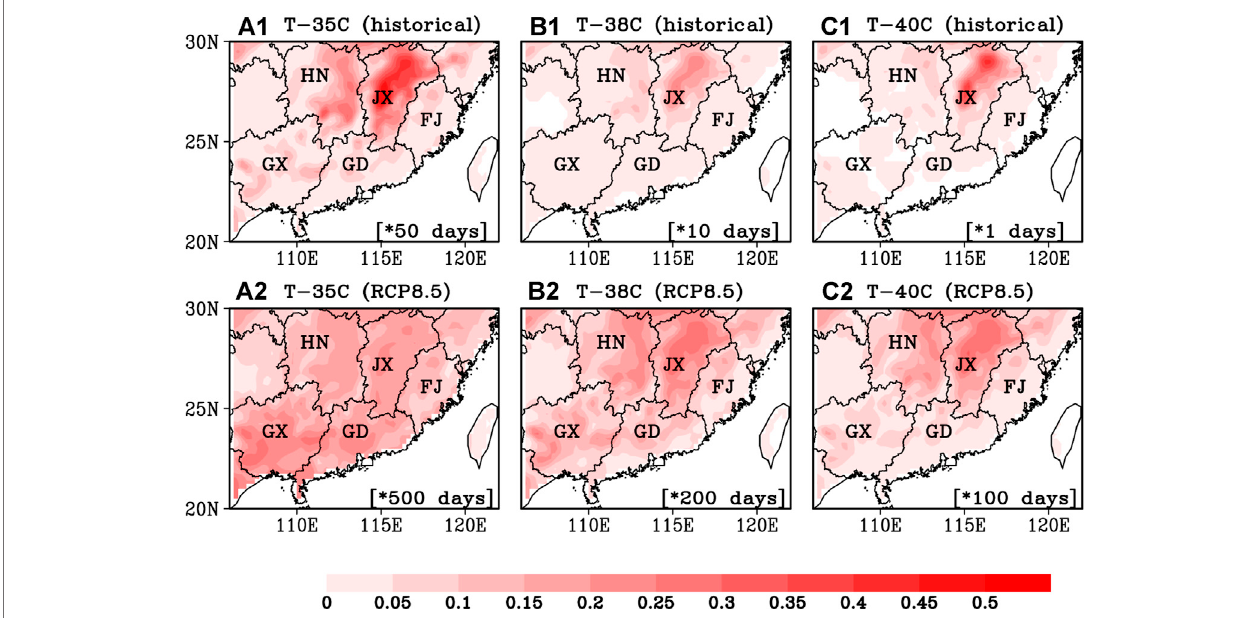
FIGURE 1 | All 21 models (in NEX-GDDP dataset) MME mean EHTDs at different T-levels averaged over historical period of 1980 – 1999, and RCP8.5 period of 2080 – 2099, within Southern China Region. To gain better visibility, the patterns in the fi gures are the results of dividing a factor shown on the bottom into the real variable